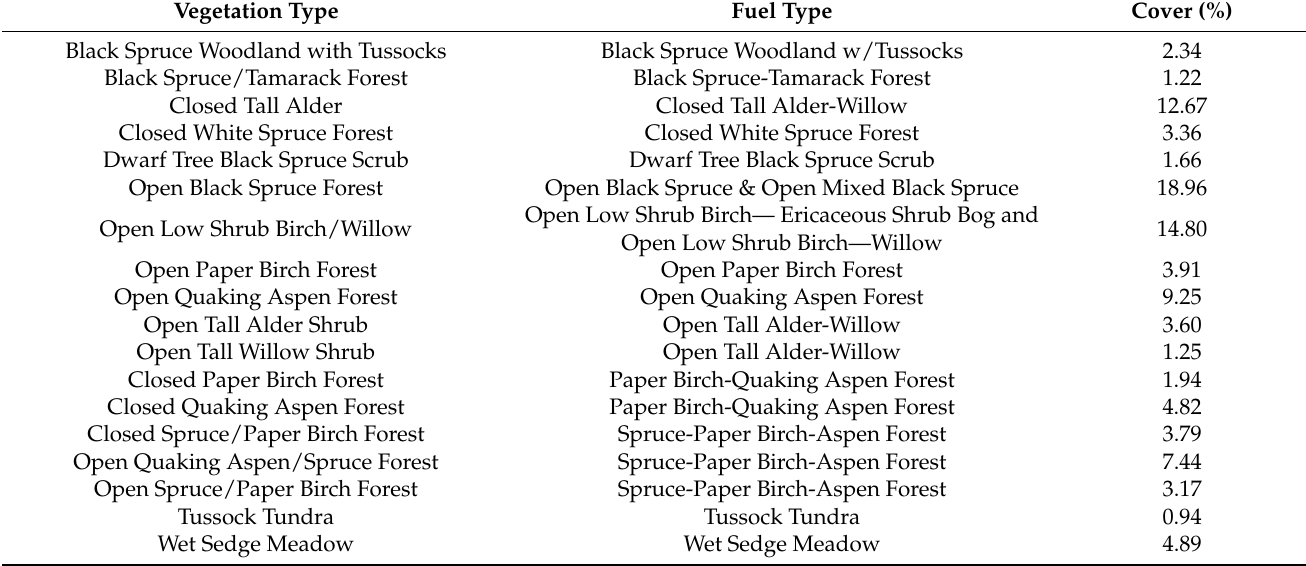
Table 5. Classified CPCRW AVIRIS-NG PCA image + DEM percent area by vegetation